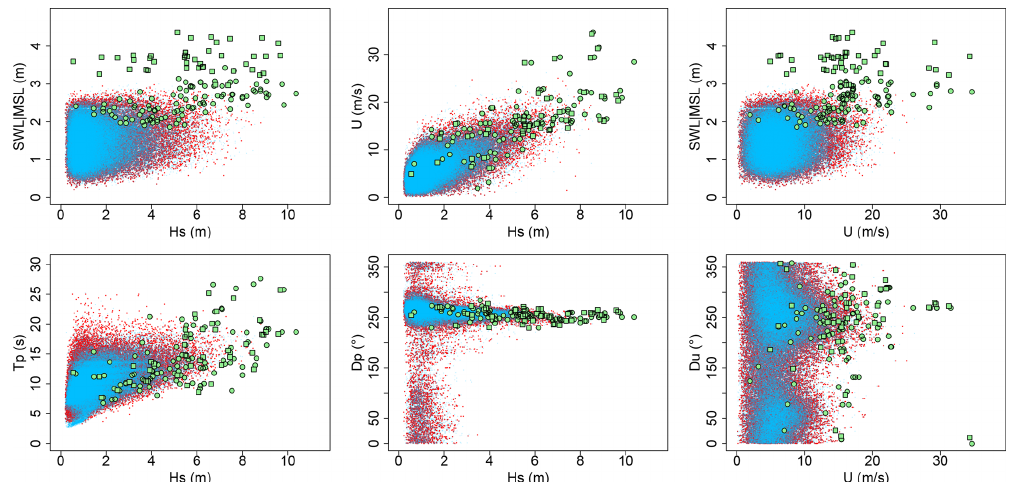
Figure 3. Overview of the N = 50000 randomly generated samples of offshore conditions (red dots). Blue dots correspond to the hindcast conditions used to fit the statistical methods described in Sect. 3.3. Green dots and squares correspond to the n = 144 training data points used to set up the GP metamodel (the selection approach is detailed in Sect. 3.2). The squares correspond to cases that are deliberately selected outside the range of the red dots to cover a broader range of situations. SWL is defined with respect to the mean sea level